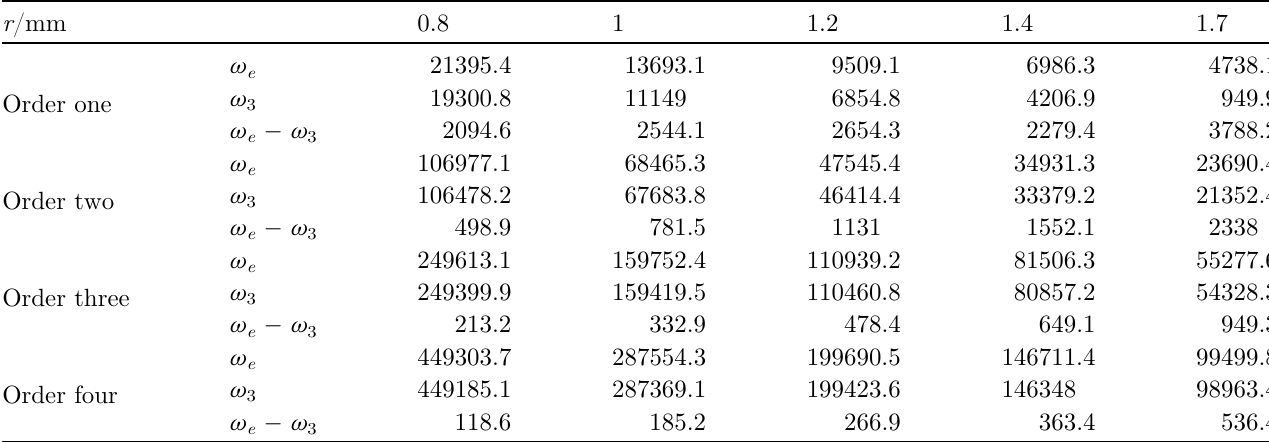
Table 3. Changes of natural frequency with r